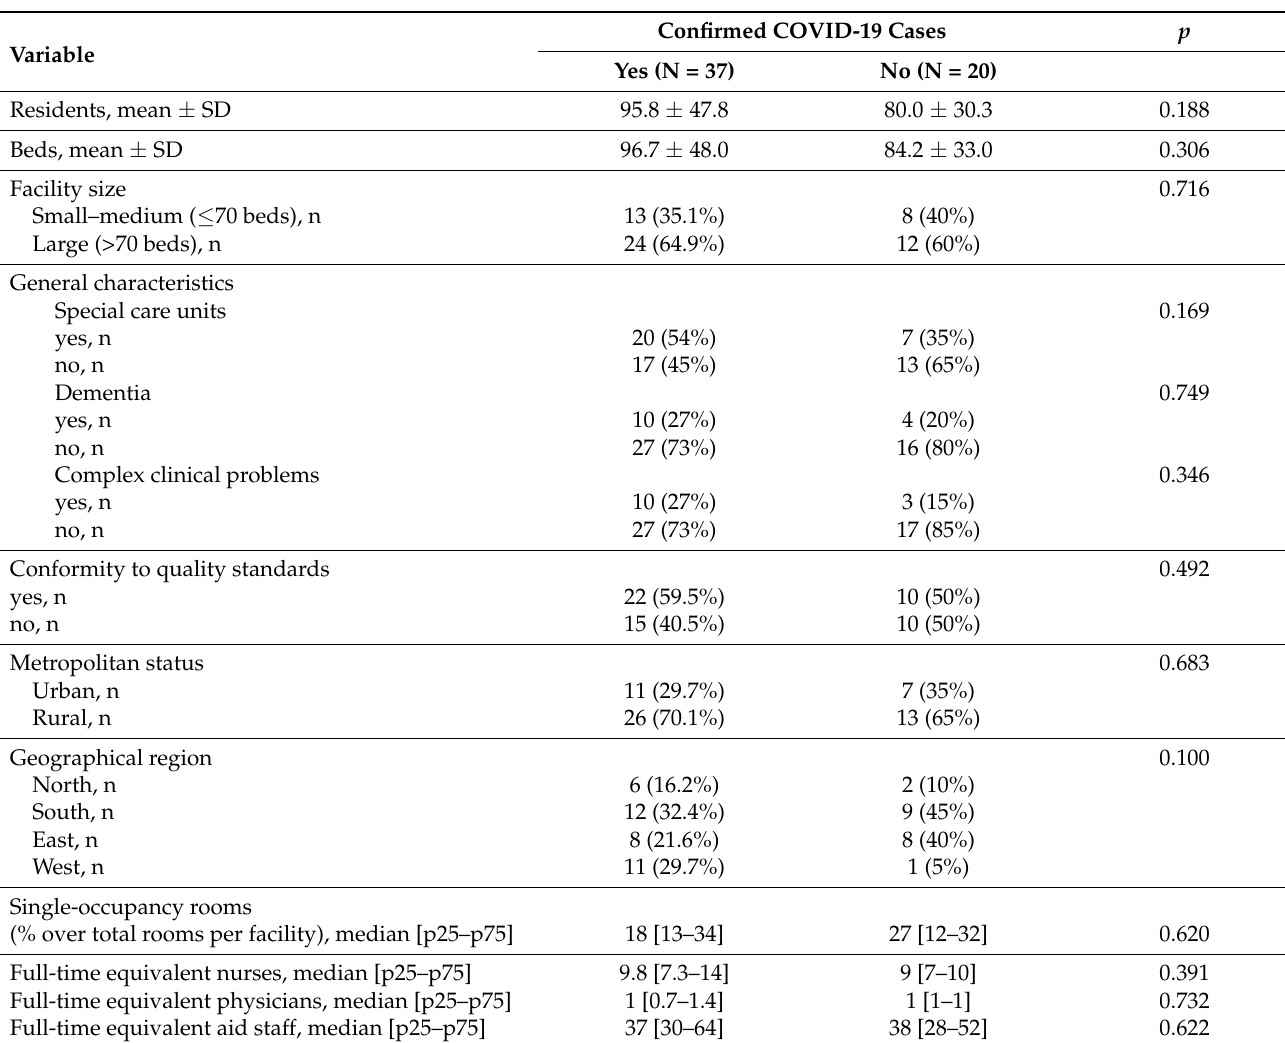
Table 3. Bivariate analyses for nursing homes in the province of Trento that reported COVID-19 cases and those that did not report any